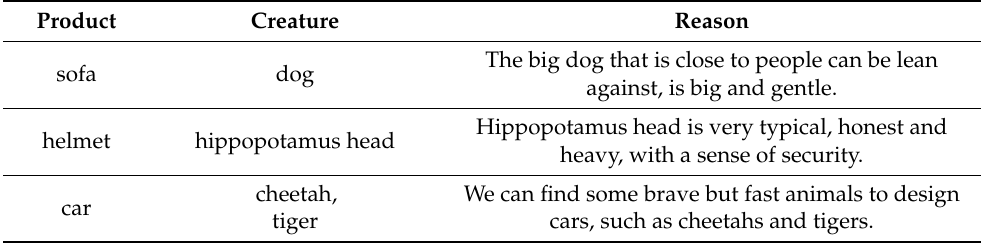
Table 1. Affective perception of product-affective perception of creature reasoning (72